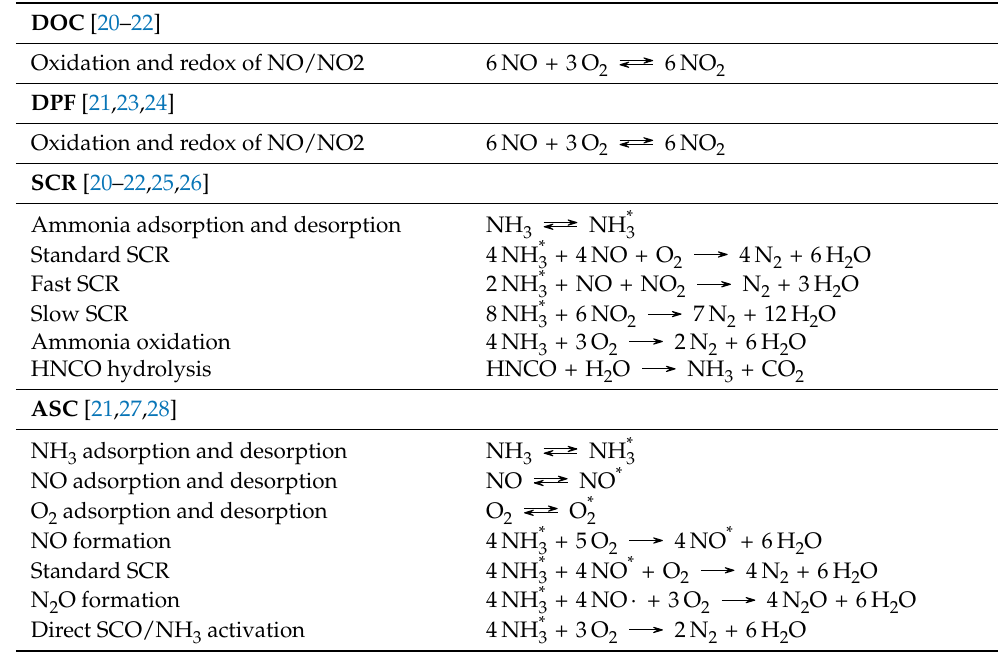
Table A1. Modeled reactions in the aftertreatment